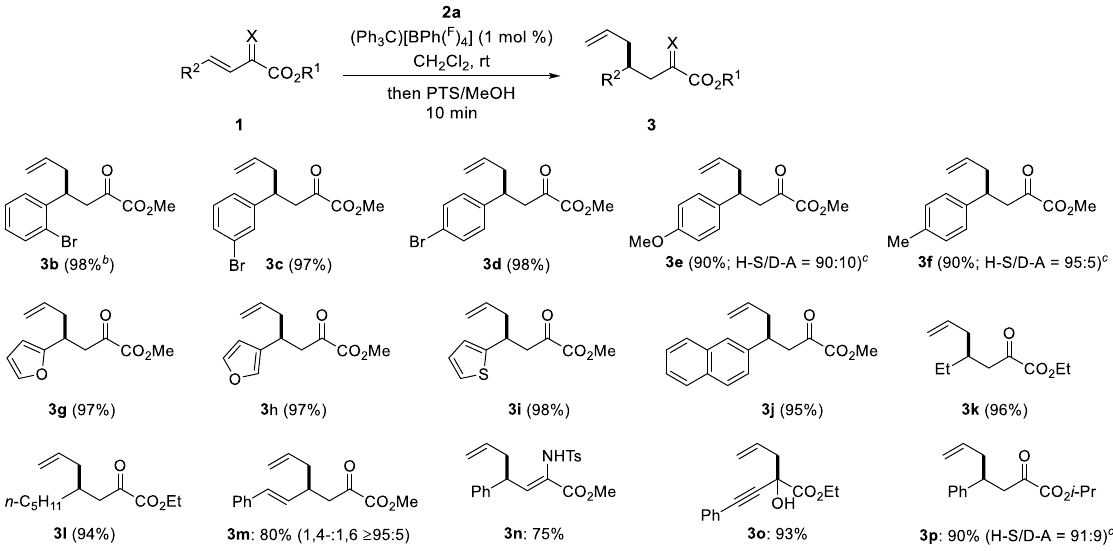
Table 2. Scope of Allylsilanes a .